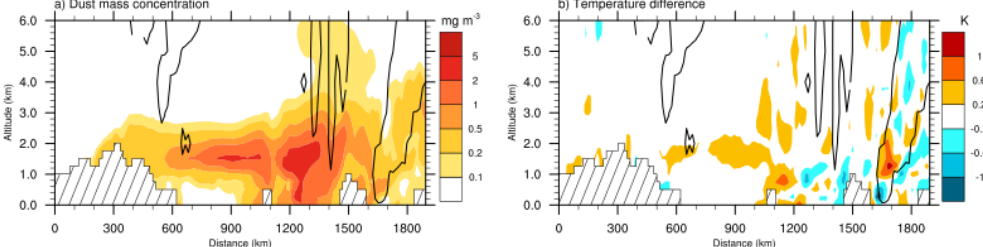
Figure 8. (a) Vertical cross section of dust concentration (color scale) and cloud condensate mixing ratio of 0.01gkg − 1 (contours) along the transect shown in Fig. 4 from 30 ◦ N, 6 ◦ W to 45 ◦ N, 5 ◦ E at 12:00UTC on 19 October 2012. The orography is also shown (hatched areas). (b) same as (a) but for the difference in temperature between DUST and NODUST (color